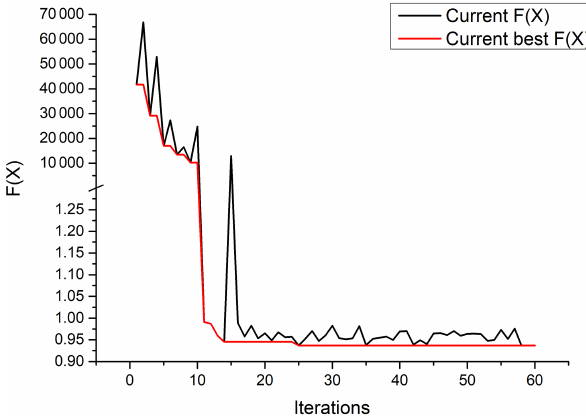
Figure 1. The change in augmentation function F(x) across the optimization iterations. The x axis is the number of iterations. The y axis is the value of F(x) in Eq. (6). The black line shows the value of F(x) in a given iteration step, while the red line shows the best F(x) value up to the current iteration step.